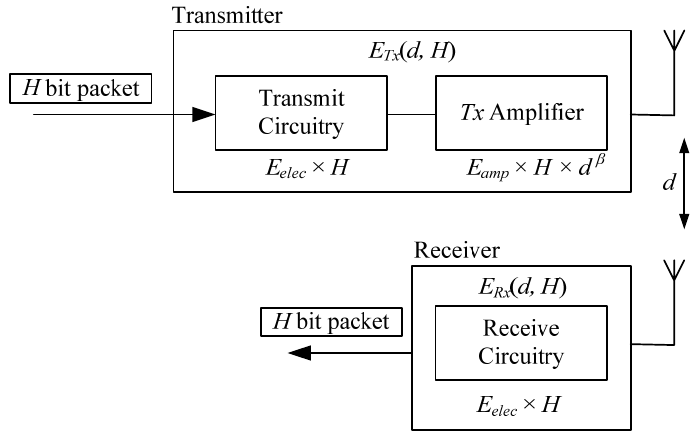
Figure 2. The energy consumption model used in this